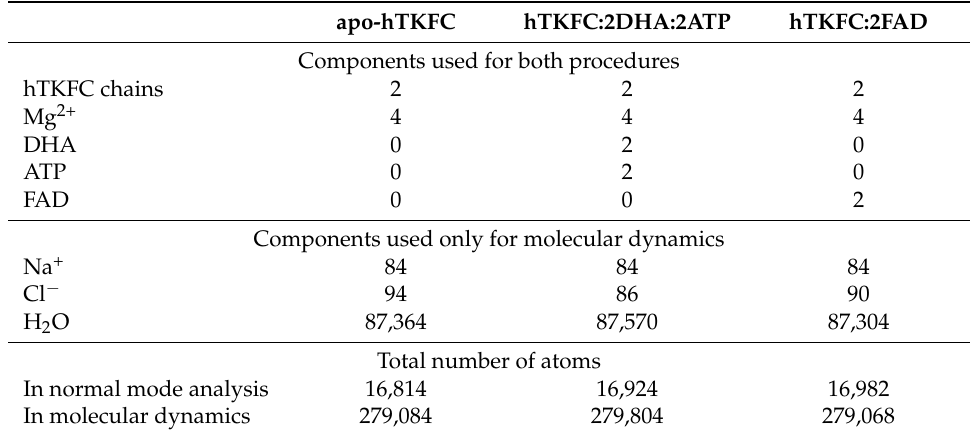
Table 1. Composition of the systems submitted to normal-mode analysis and molecular